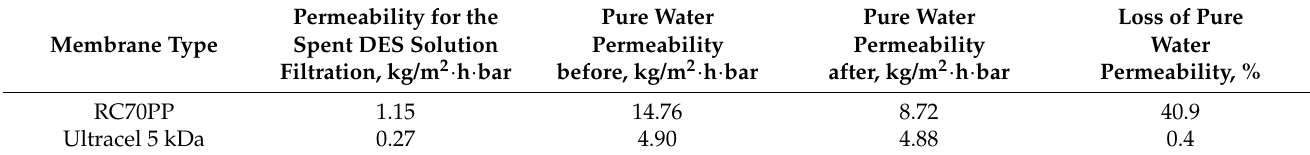
Table 4. Permeability of the spent DES solution filtration and pure water permeabilities before and after UF through RC70PP and Ultracel 5 kDa, Amicon cell unit. Parameters of the spent DES solution filtration: 3.5 bar, 45 ◦ C, 250 rpm. Parameters of the pure water filtration: 10 min at 2 bar, 3 bar, 4 bar, 21 ◦ C, 250